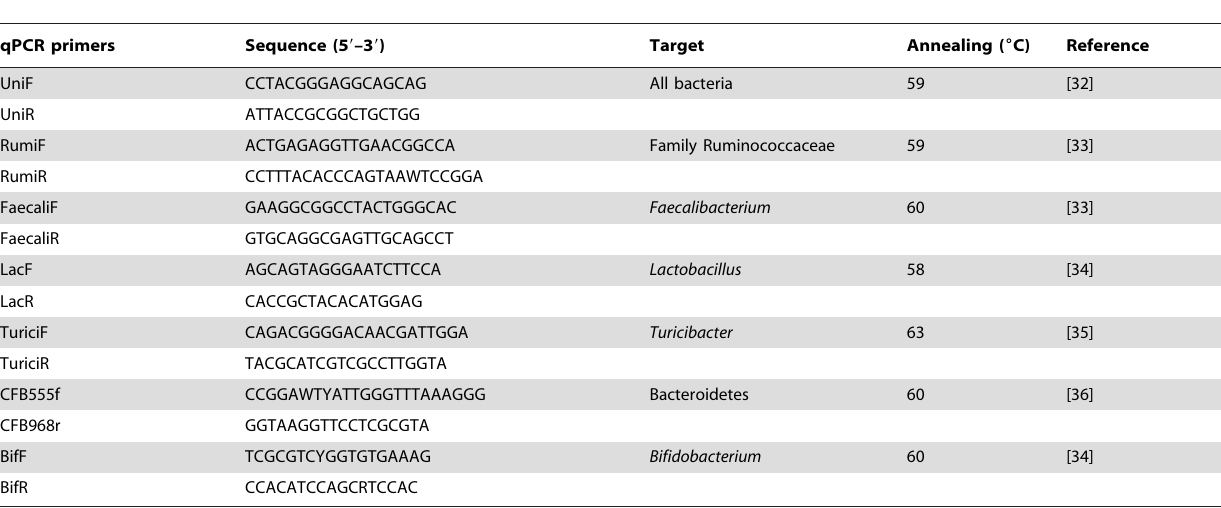
Table 1. Oligonucleotides used in this study for qPCR